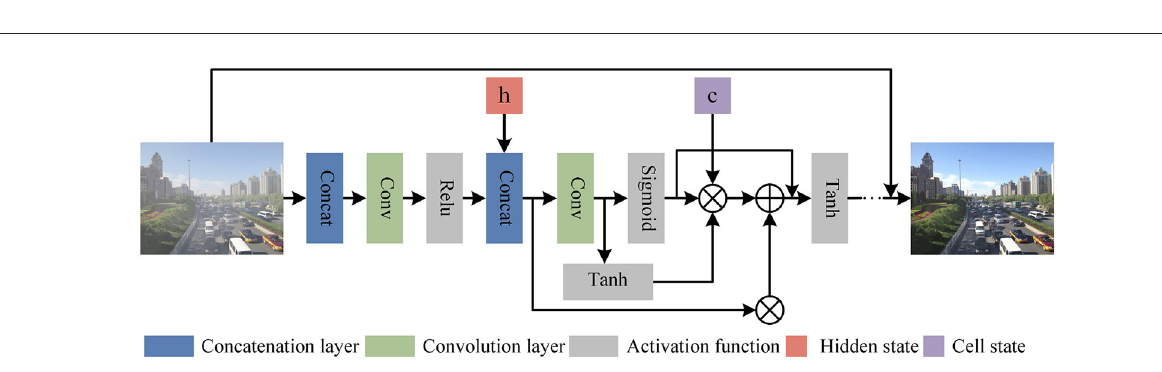
the t − 1 iteration and the previous hidden state h t − 1 .